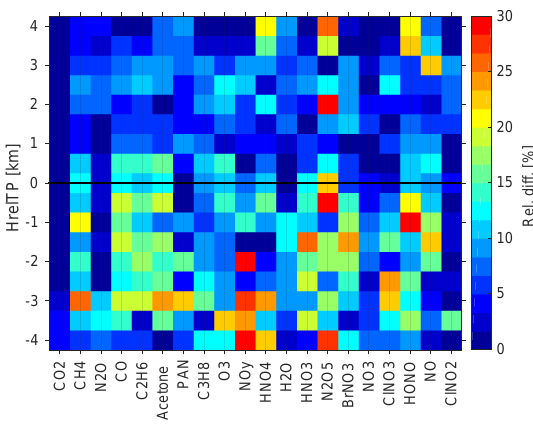
− 1 | , given in percent. This is the frac- /R B Figure A2. | R A rel rel tion of the representativeness uncertainty introduced in R rel cal- culated from MOD regular and MOD RANDLOC by including the CARIBIC Pacific ocean in MOD RANDLOC , even though it is not sam- Figure B1. Time series of CO for flight 445 from Frankfurt to pled by MOD regular . Both R A and R B have been calculated CARIBIC rel rel Tokyo. Shown is the time series of the interpolated model data from MOD regular and MOD RANDLOC , excluding the Pacific in CARIBIC and of the measurements. Measurements have been smoothed three MOD RANDLOC in the calculation of R B . rel times. The number indicates the length of the smoothing interval N